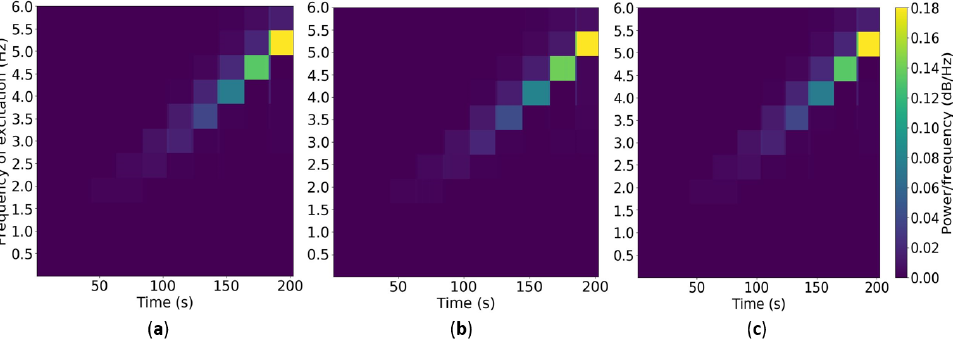
Figure 17. Spectrograms for the 0.50 cm displacement frequency chirp: ( a ) PCB L74 spectrogram.